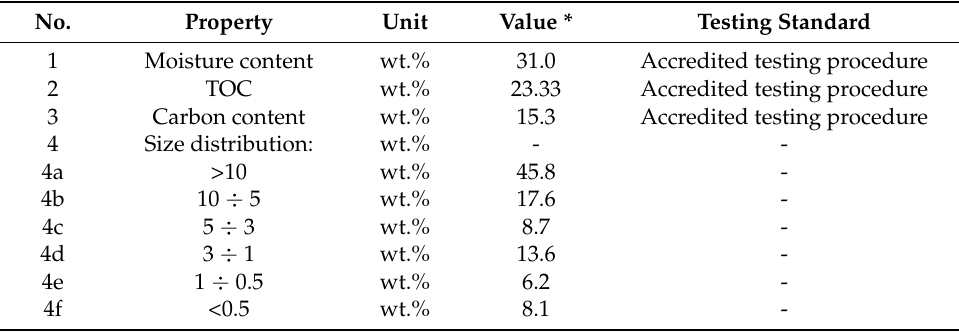
Table 2. Properties of the mixed slag and fly ash from the grate